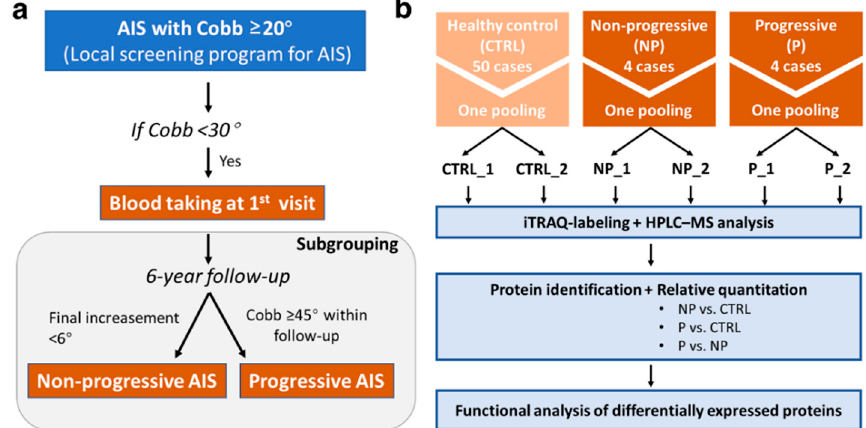
Figure 1. Proteomic analysis of the plasma in the healthy control (CTRL) vs. non-progressive (NP) vs. progressive (P) AIS groups. ( a ) Illustration of the selection criteria for the AIS groups. ( b ) Main procedures of sample pooling, iTRAQ labeling, HPLC–MS analysis, and bioinformatic analysis.